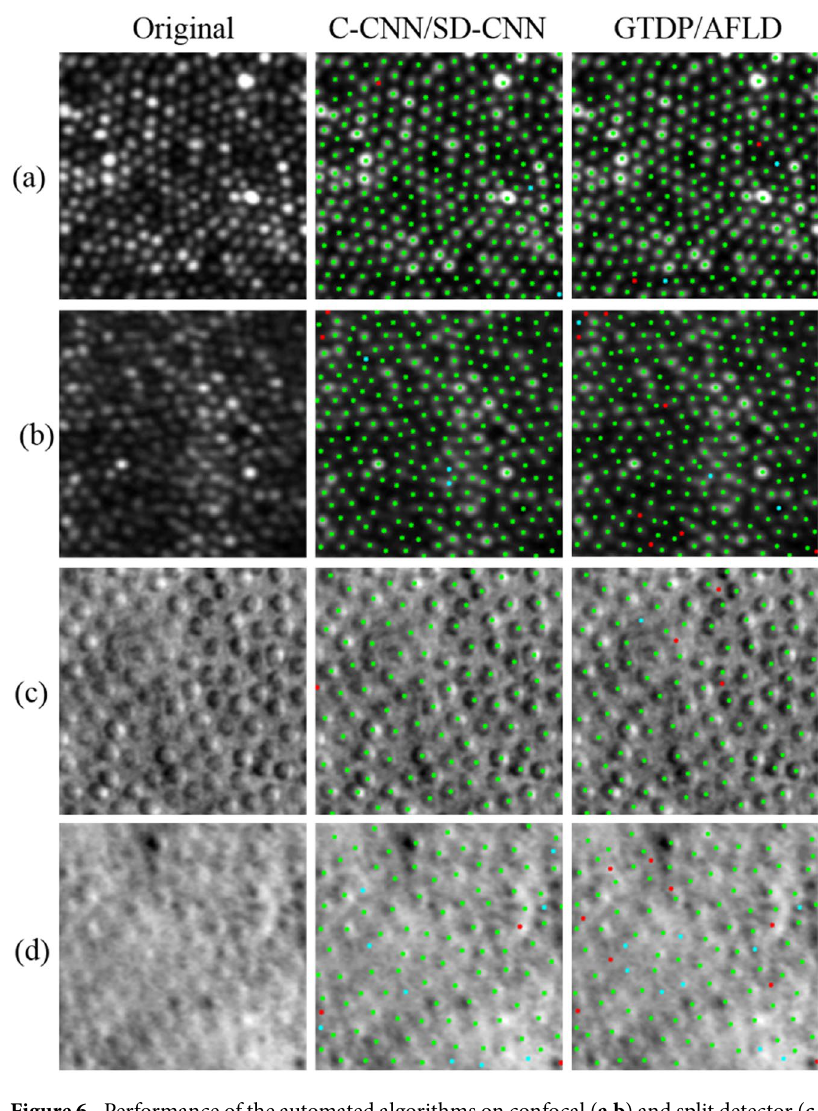
Figure 6. Performance of the automated algorithms on confocal ( a , b ) and split detector ( c , d ) images. Original Images are shown in the left column, C-CNN for confocal and SD-CNN for split detector cone detection results in the middle column, and AFLD for split detector and GTDP for confocal results in the right column. Green points denote true positives, cyan denotes false negatives, and red denotes false positives. Dice’s coefficients for our CNN based method are 0.994 in ( a ), 0.990 in ( b ), 0.995 in ( c ), and 0.941 in ( d ). Dice’s coefficient for the GTDP method are 0.992 in ( a ) and 0.978 in ( b ), and for the AFLD method are 0.979 in ( c ) and 0.911 in ( d ).